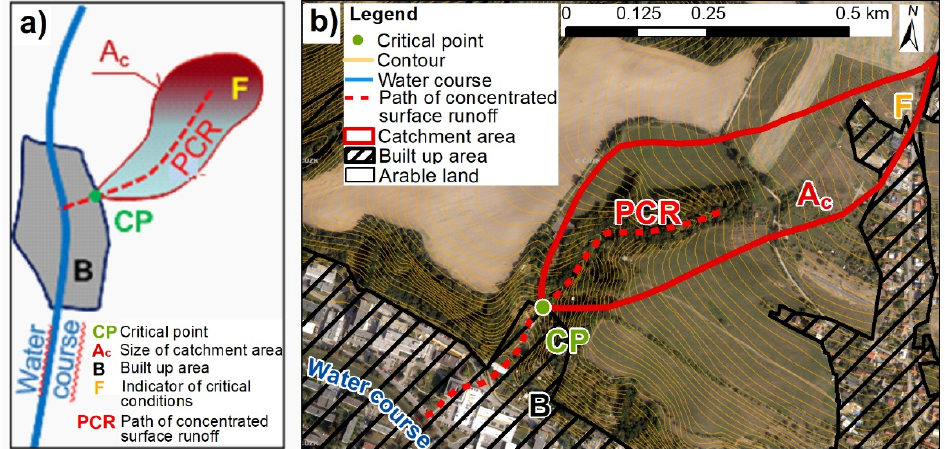
Figure 2. Identification of a critical point at the intersection of a path of concentrated surface run-off and a built-up area boundary, and the size of catchment area with the indicator of critical conditions: ( a ) diagram and ( b ) orthophotomap.